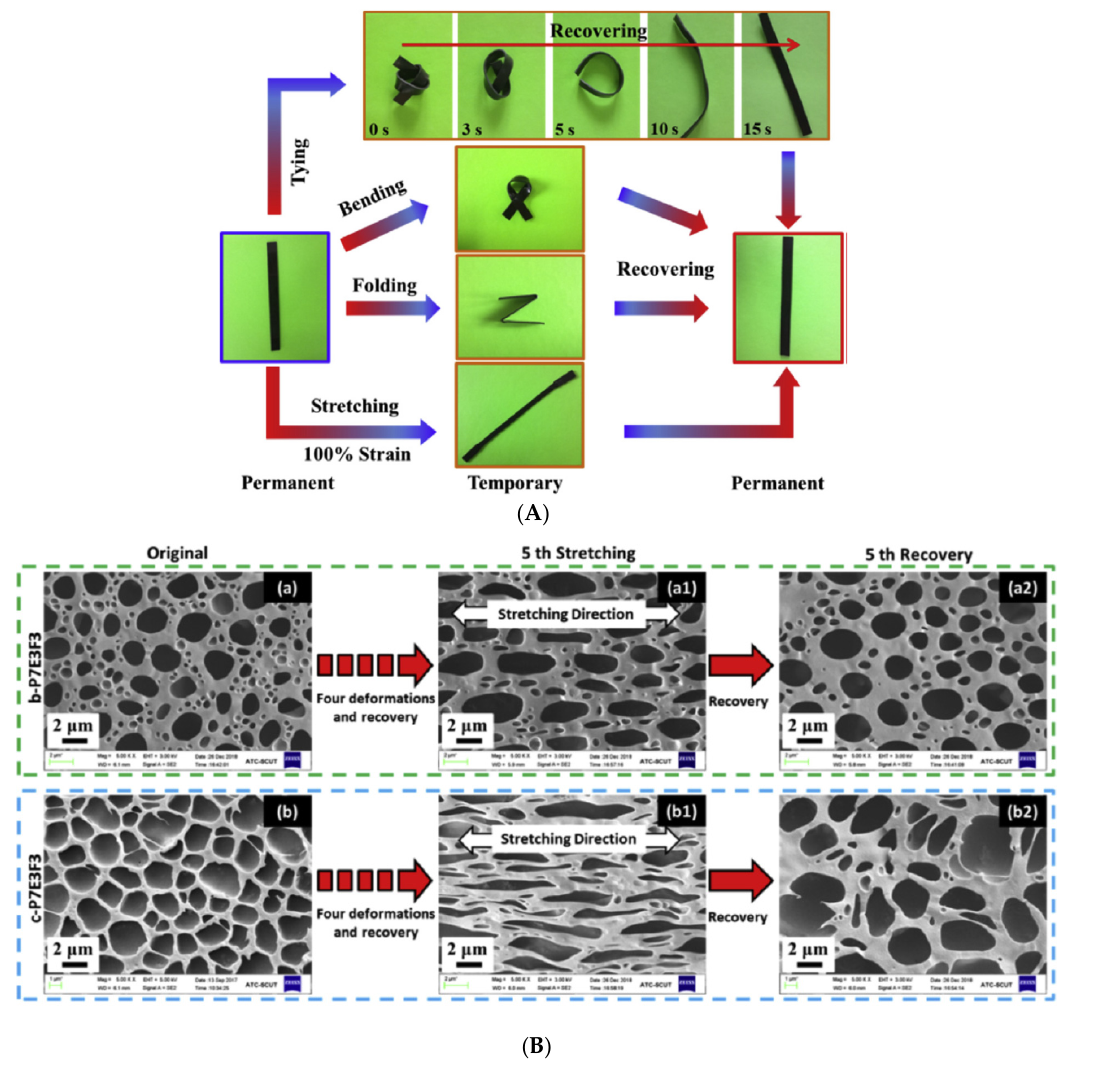
Figure 7. ( A ) Photographs of the shape recovery process of the PLA/ENR/Fe 3 O 4 TPVs. ( B ) Scanned electron microscopy images of solvent-etched PLA/ENR/Fe 3 O 4 TPVs (Reproduced with permission from [76], Elsevier, 2019).